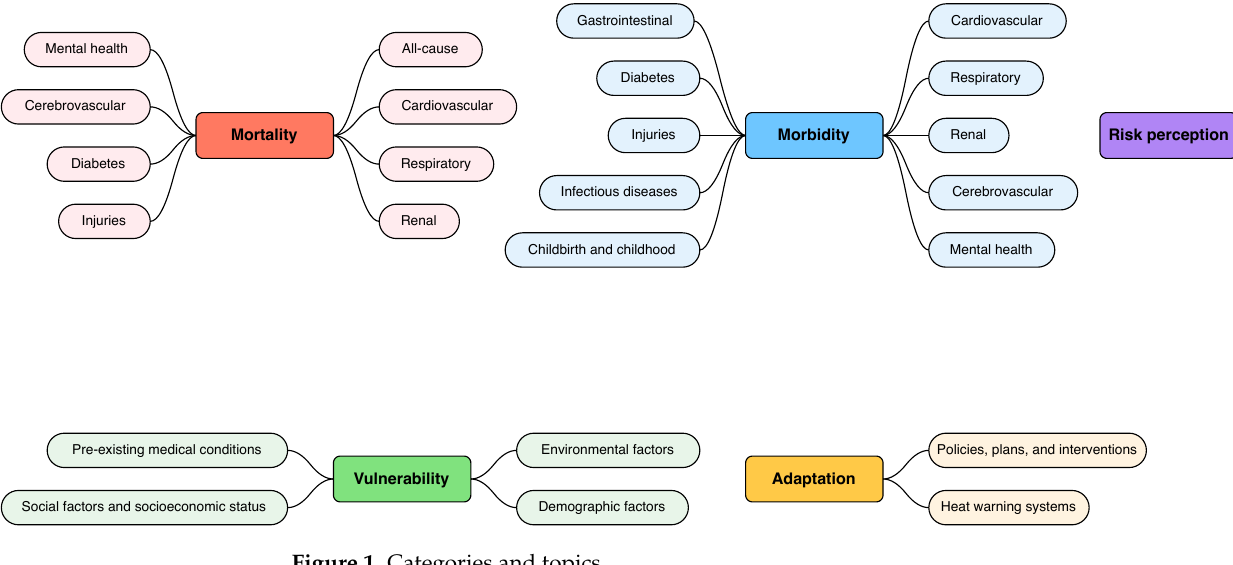
Figure 1. Categories and